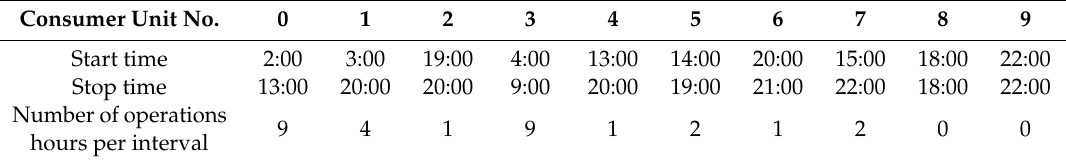
Table 2. Consumer schedule for a profile (case study) generated by simulator.